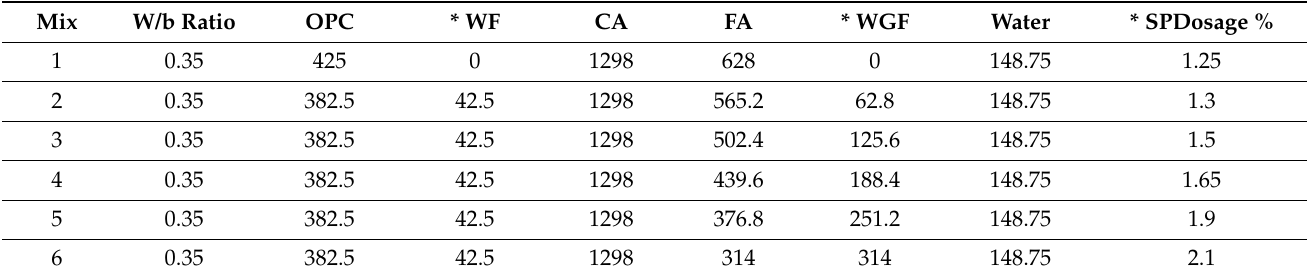
Table 2. Mix design of concrete (kg/m 3 ) based on Ref.